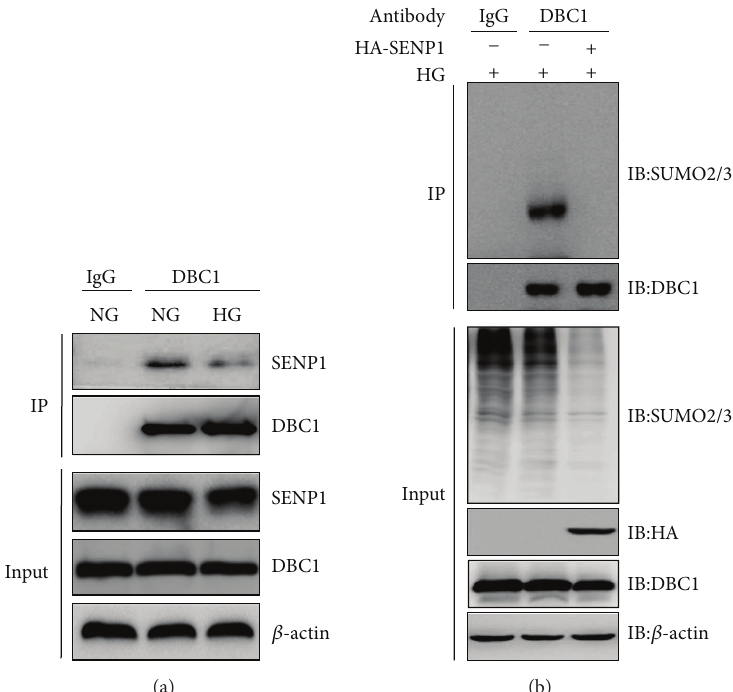
Figure 5: SENP1 inhibited the DBC1 sumoylation induced by high glucose. (a) BRPCs incubated with normal (NG) or high glucose (HG) for 48 h were subjected to immunoprecipitation with IgG or anti-DBC1 antibody followed by immunoblot analysis. (b) SENP1 was overexpressed in BRPCs under high glucose for 48h. Their lysates were subjected to immunoprecipitation with IgG or anti-DBC1 antibody followed by immunoblot